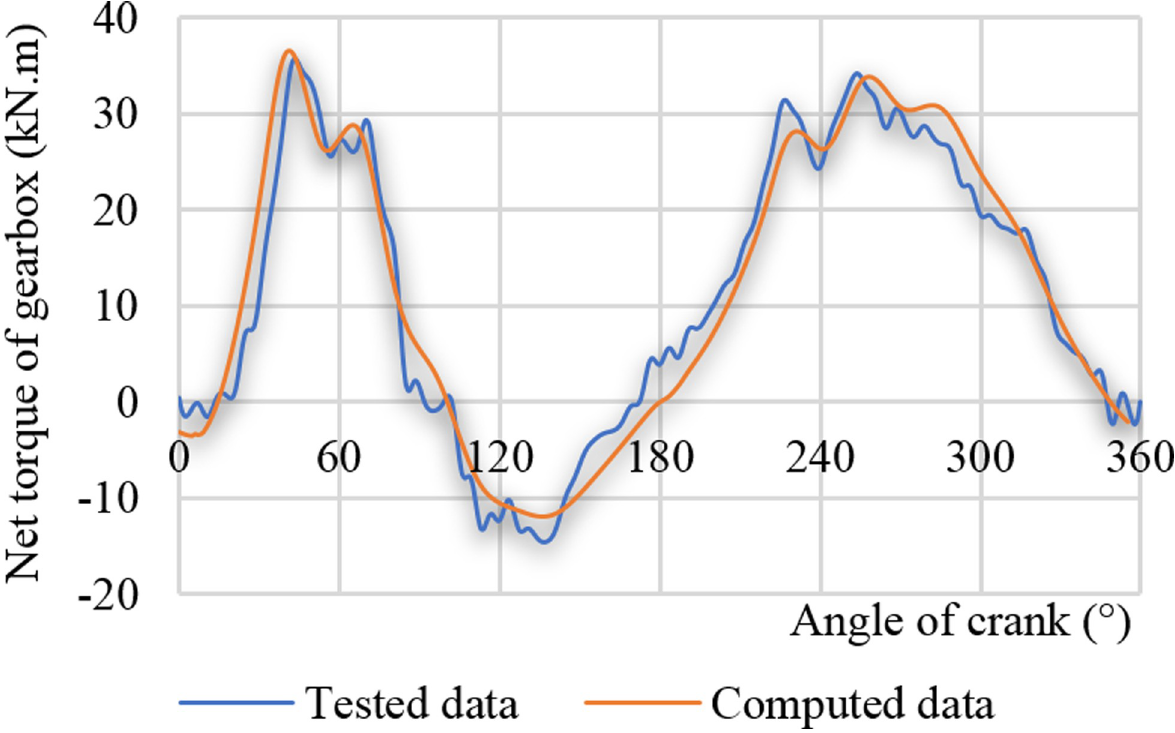
Fig 12. Net torque curves of the gearbox (YCHD280L-37 kW).